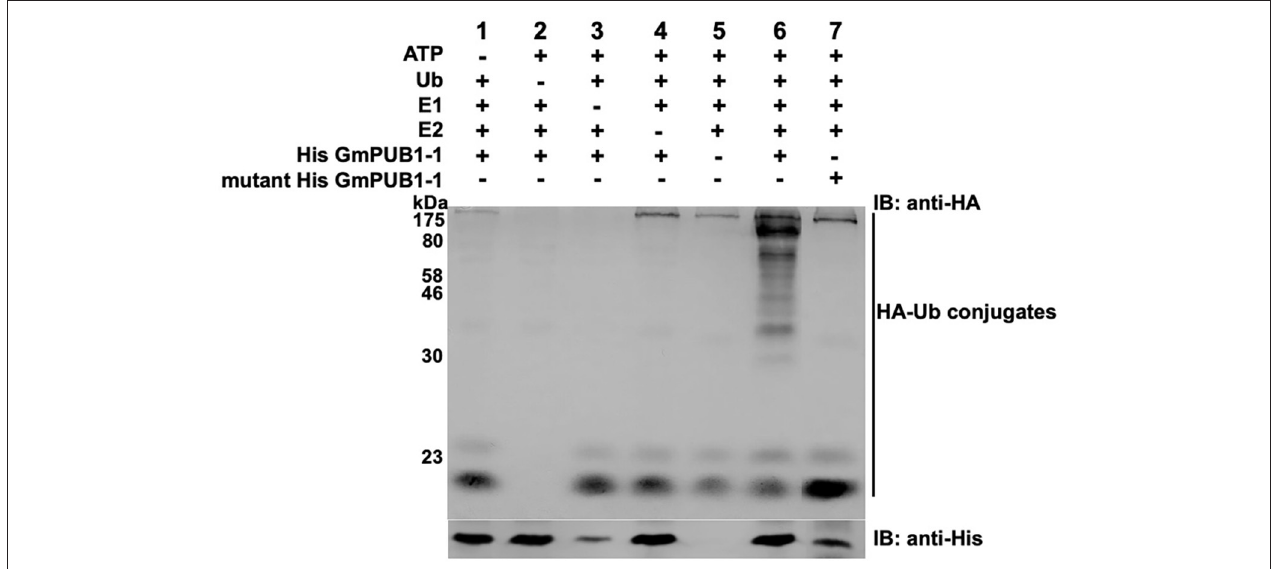
FIGURE 3 | E3 Ubiquitin ligase activity of GmPUB1-1. In vitro ubiquitination assay with E. coli expressed His-GmPUB1-1 was performed in presence of combination of components as listed on top of the Figure. As a negative control for the E3 activity, a mutated version of His-GmPUB1-1 was used (three conserved amino acid residues Cys-12, Val23 and Trp-39 mutated to Ala, Ile and Ala respectively, in U-box domain). The immunoblots were probed with anti-HA antibody (top) to detect ubiquitinated E. coli proteins. Anti-His antibody (bottom) was used to detect His-GmPUB1-1 ( ∼ 48 kDa) and its mutated version. Numbers on the left are molecular weight markers in